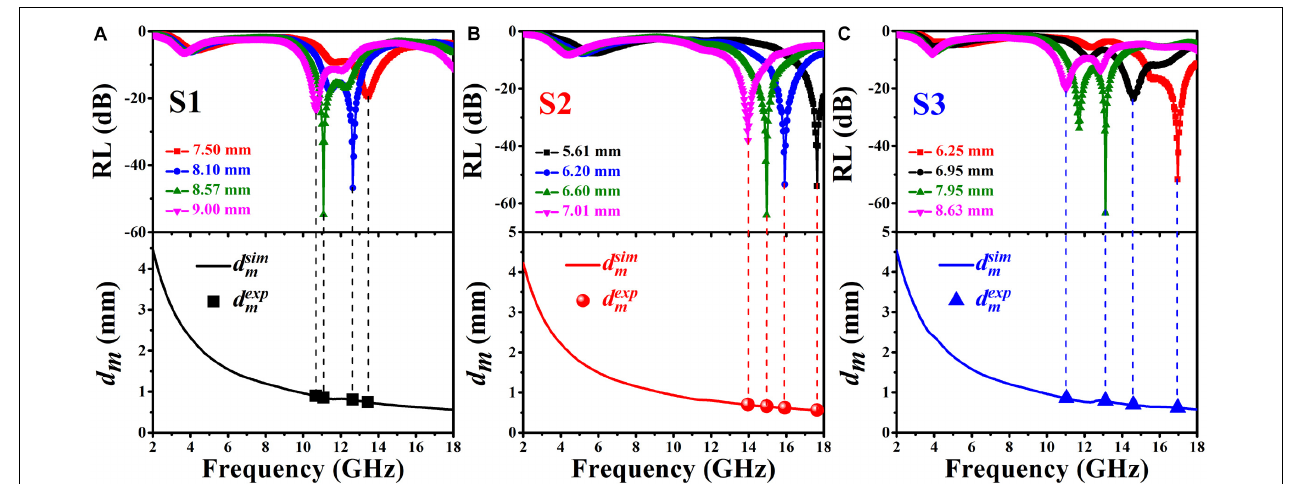
FIGURE 12 | Comparison results between the calculated and experimental matching thicknesses for (A) S1, (B) S2, and (C) S3.